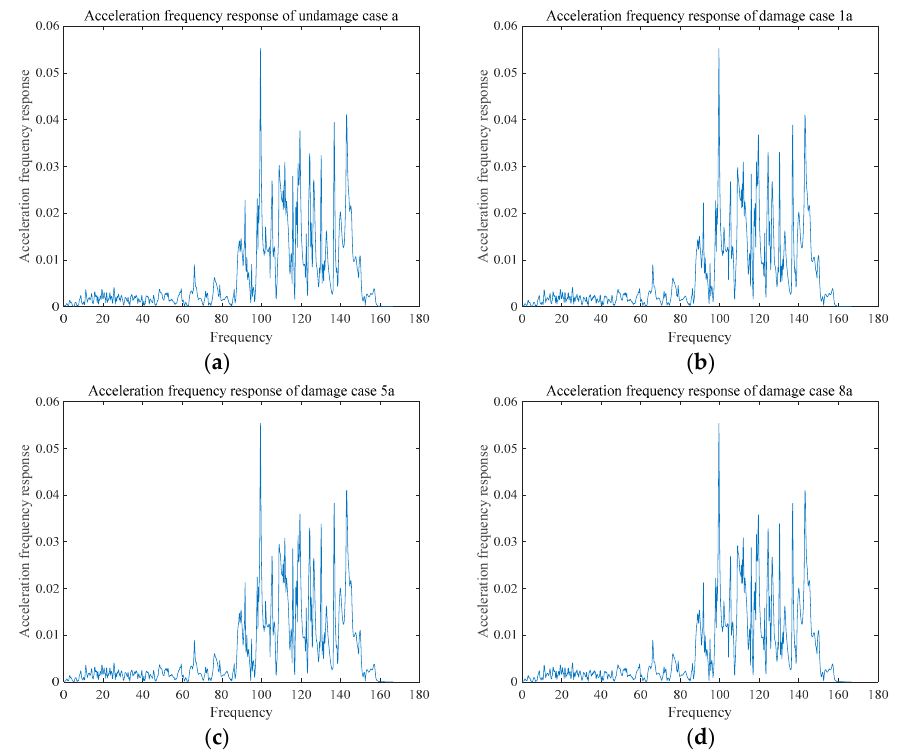
Figure 11. Acceleration frequency response of Group A: ( a ) UDMa; ( b ) DMG1a; ( c ) DMG5a; and, ( d )